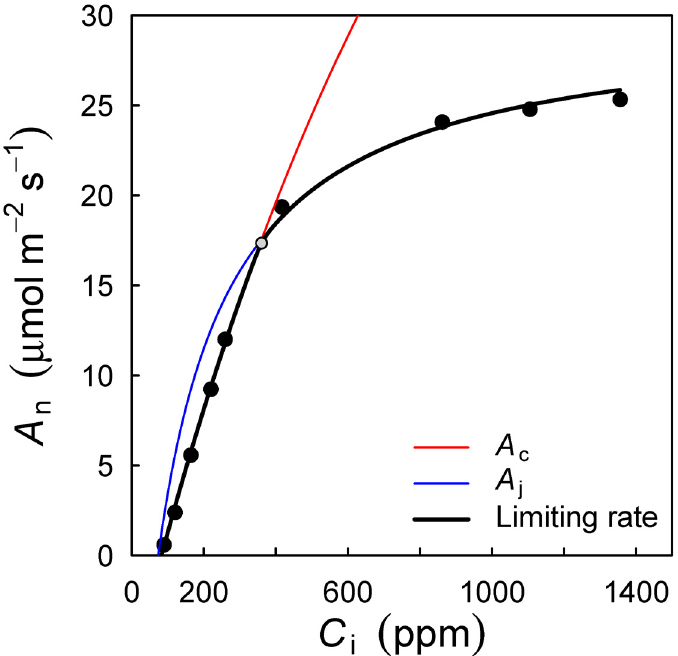
Fig 2. Standard output from the fitaci function. A n is the net photosynthetic rate, C i the intercellular CO 2 concentration. Symbols are measurements, the black line the fitted FvCB model of photosynthesis. Colored lines indicate the two photosynthesis rates in the FvCB model. In the default mode, the fitaci function estimates V cmax , J max and R d from the fitted curve. Optionally, R d is provided as an input, for example when it was measured separately. In this example, V cmax was estimated as 46.8 (SE 1.47), J max was 105.2 (SE 1.36) and R d was 1.3 (SE 0.24). Assumed parameters were K m = 1460 and Γ * = 64.8 (all in units of μ mol m -2 s -1 ). The R 2 of a regression of measured vs. fitted was